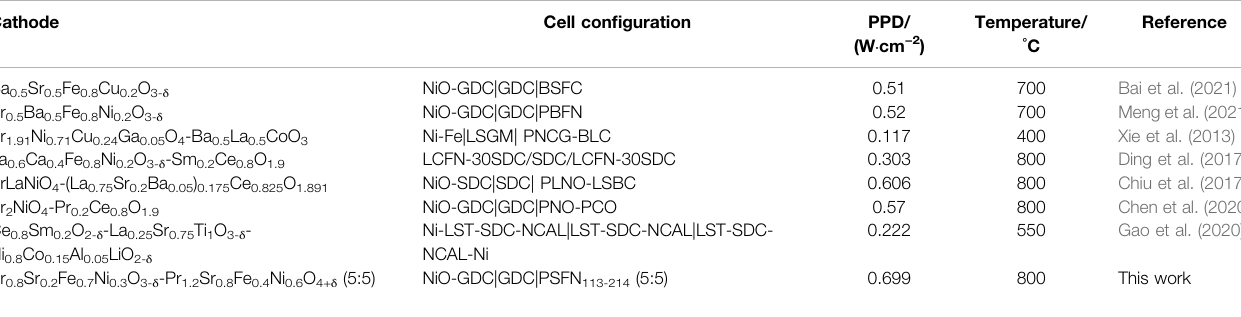
TABLE 4 | Comparison table of PPD value of PSFN cathode and other cathode reported in literature.